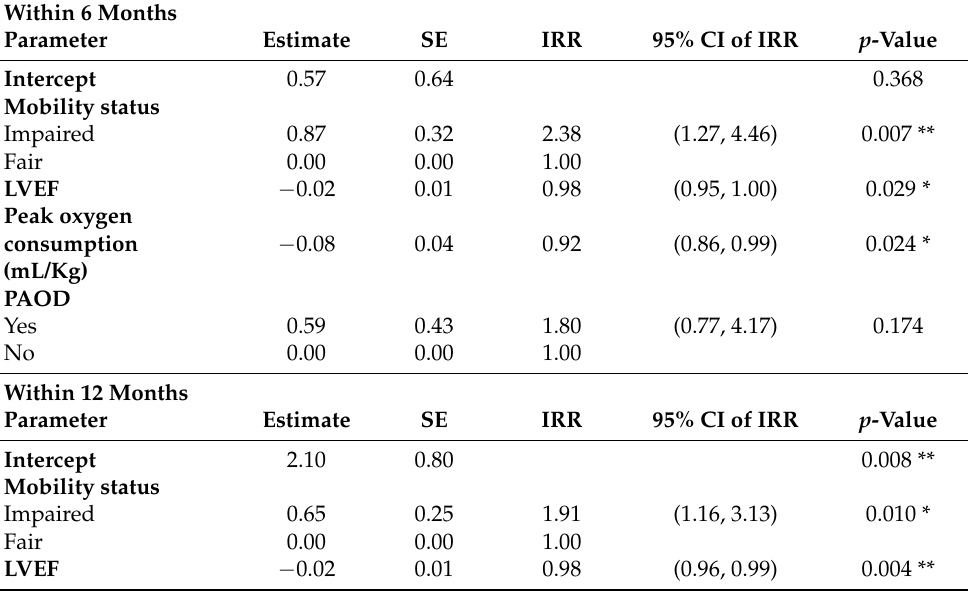
Table 4. Poisson regression model for cardiovascular rehospitalizations within 6 and 12 months after cardiac